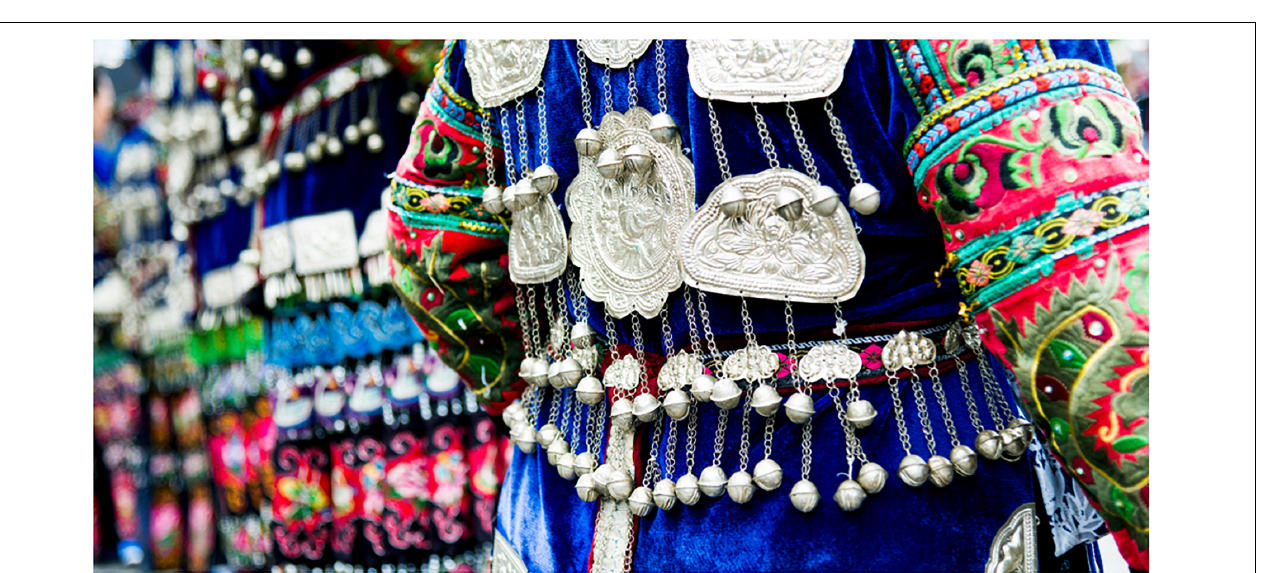
Frontiers in Psychology |